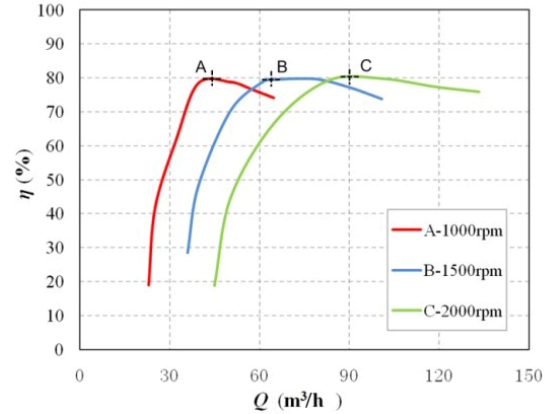
4 of 19 Figure 3. 2D hydraulic drawing of hydraulic turbine. Table 1. Main geometric parameters of the turbine. Parameter